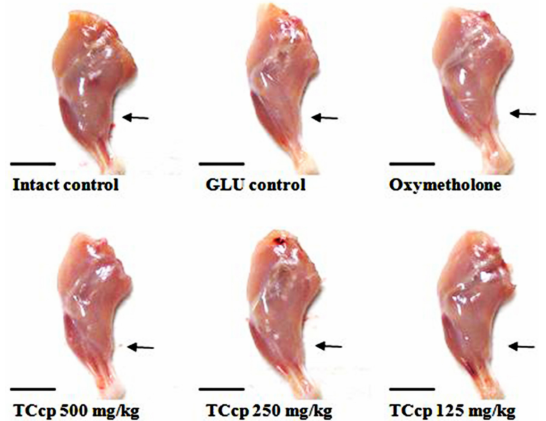
Figure 3. Variations in calf muscle masses in GLU-induced muscular atrophic mice. The thickness of left hind calf was measured at day 24 of test material administration using an electronic digital caliper and shown as mm/mouse levels. TCcp = tart cherry concentrated powder. GLU = glucocorticoid. DEXA = dexamethasone. Scale bars = 9